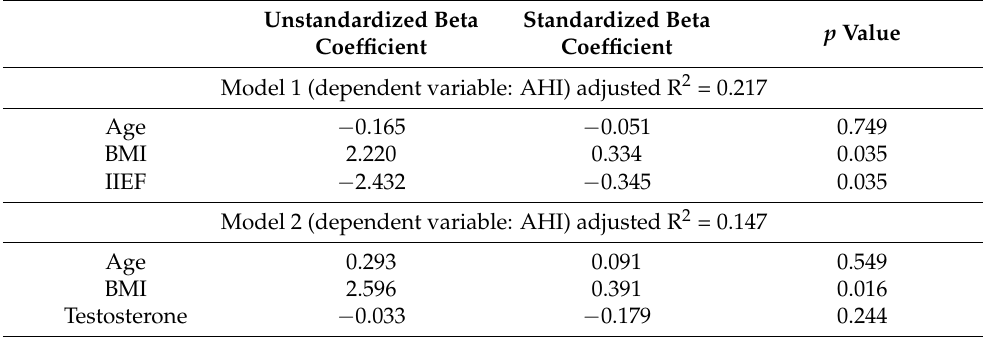
Table 3. Multiple linear regression model evaluating the association of AHI with covariates.